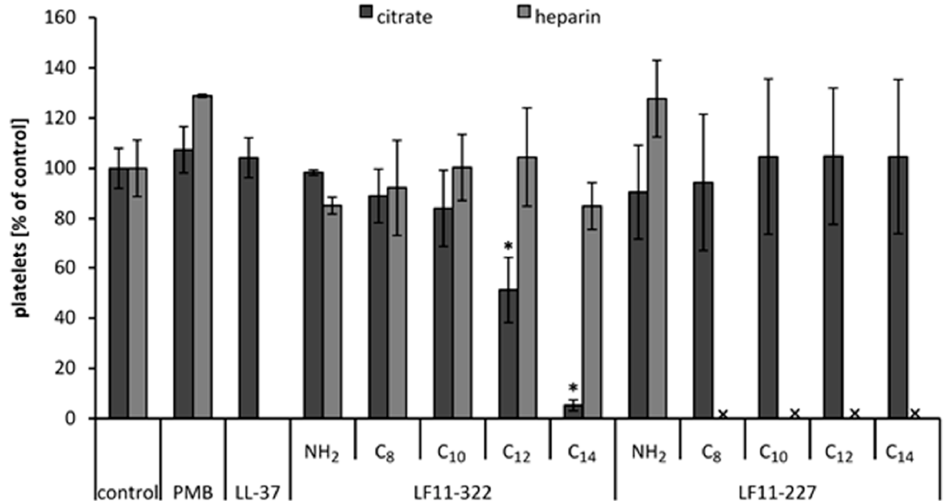
Figure 6. Influence of AMPs on platelets. PRP, anticoagulated with heparin or citrate, was incubated with 128 µg/mL AMP, PMB and LL-37. After 2 h, incubation platelets were counted. PRP without AMPs served as control and was set to 100%. The bars marked with * show a significantly ( p < 0.05) lower platelet count than the control. x marks the peptides which caused precipitates in heparinized PRP and therefore meant that a platelet count was not feasible ( n = 3).